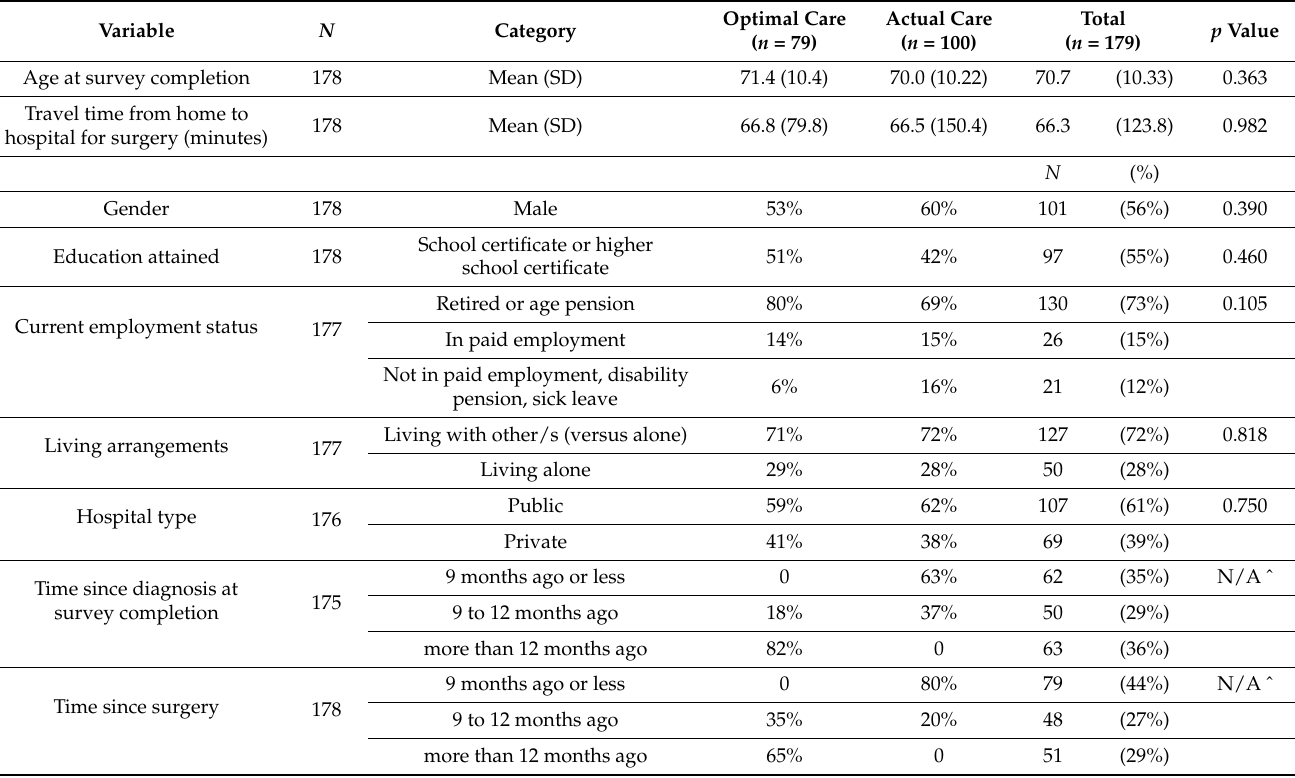
Table 2. Demographic, disease and treatment characteristics of